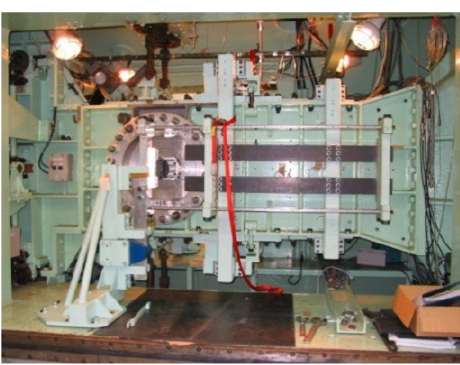
Figure 1. JAXA’s Transonic Flutter Wind-tunnel.